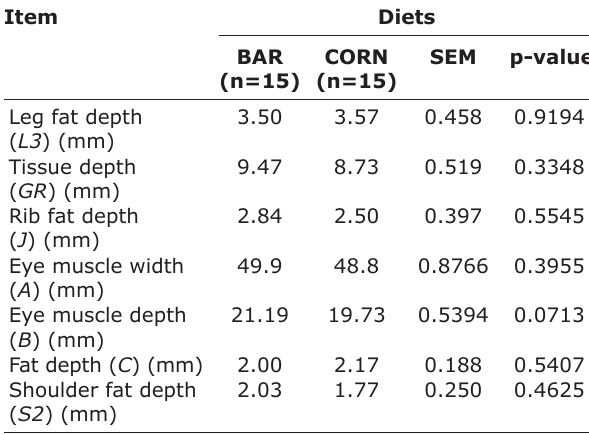
Table-6: Effects of feeding either BAR or CORN grains on carcass leaner dimensions of Awassi lambs. Item